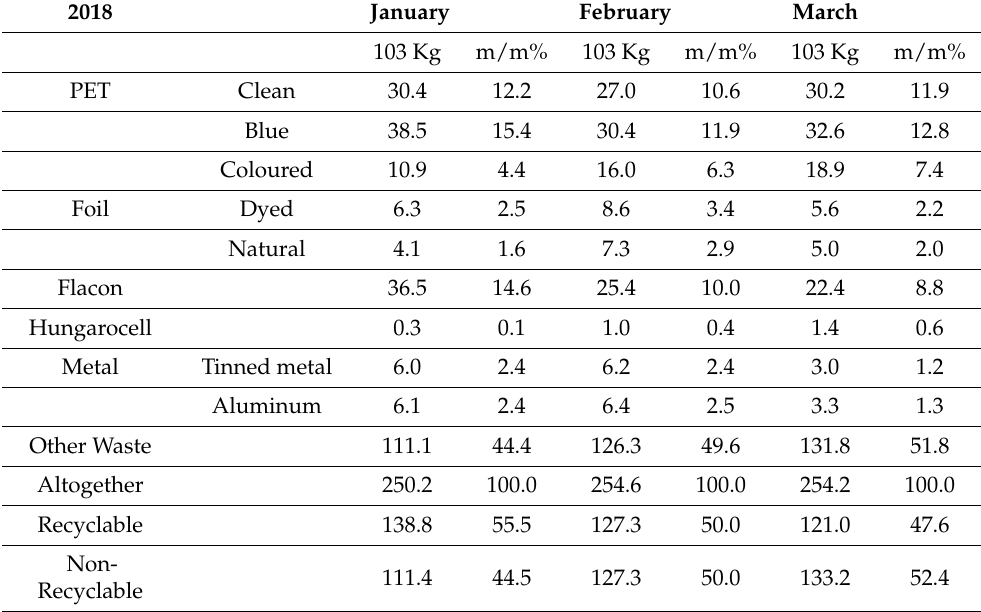
Table 1. Ratio and types of collected selective waste during the first trimester 2018.